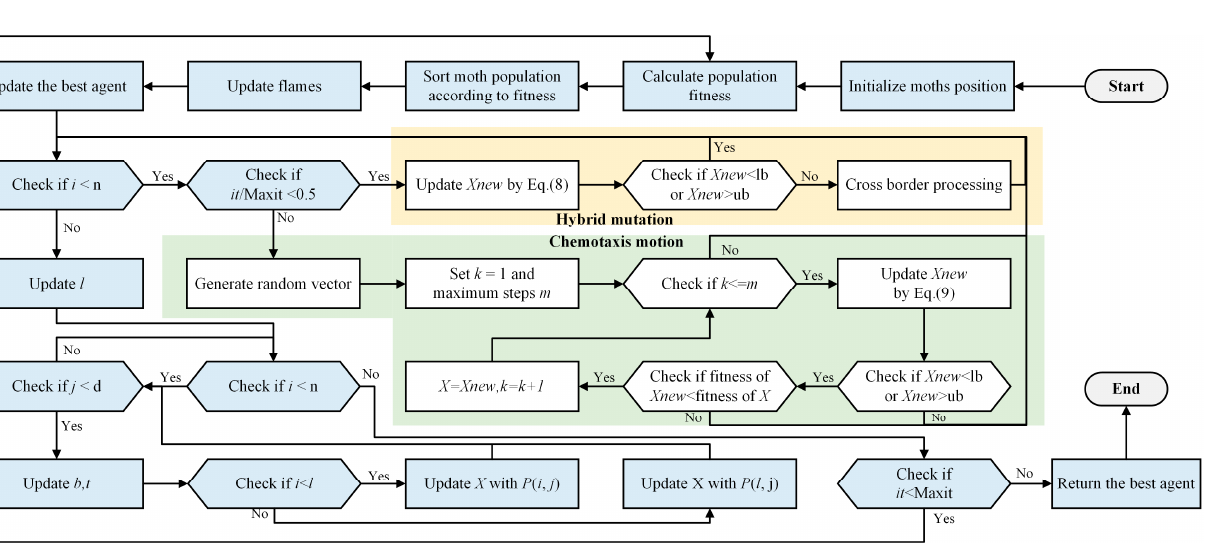
Figure 1. Flow chart of HMCMMFO.